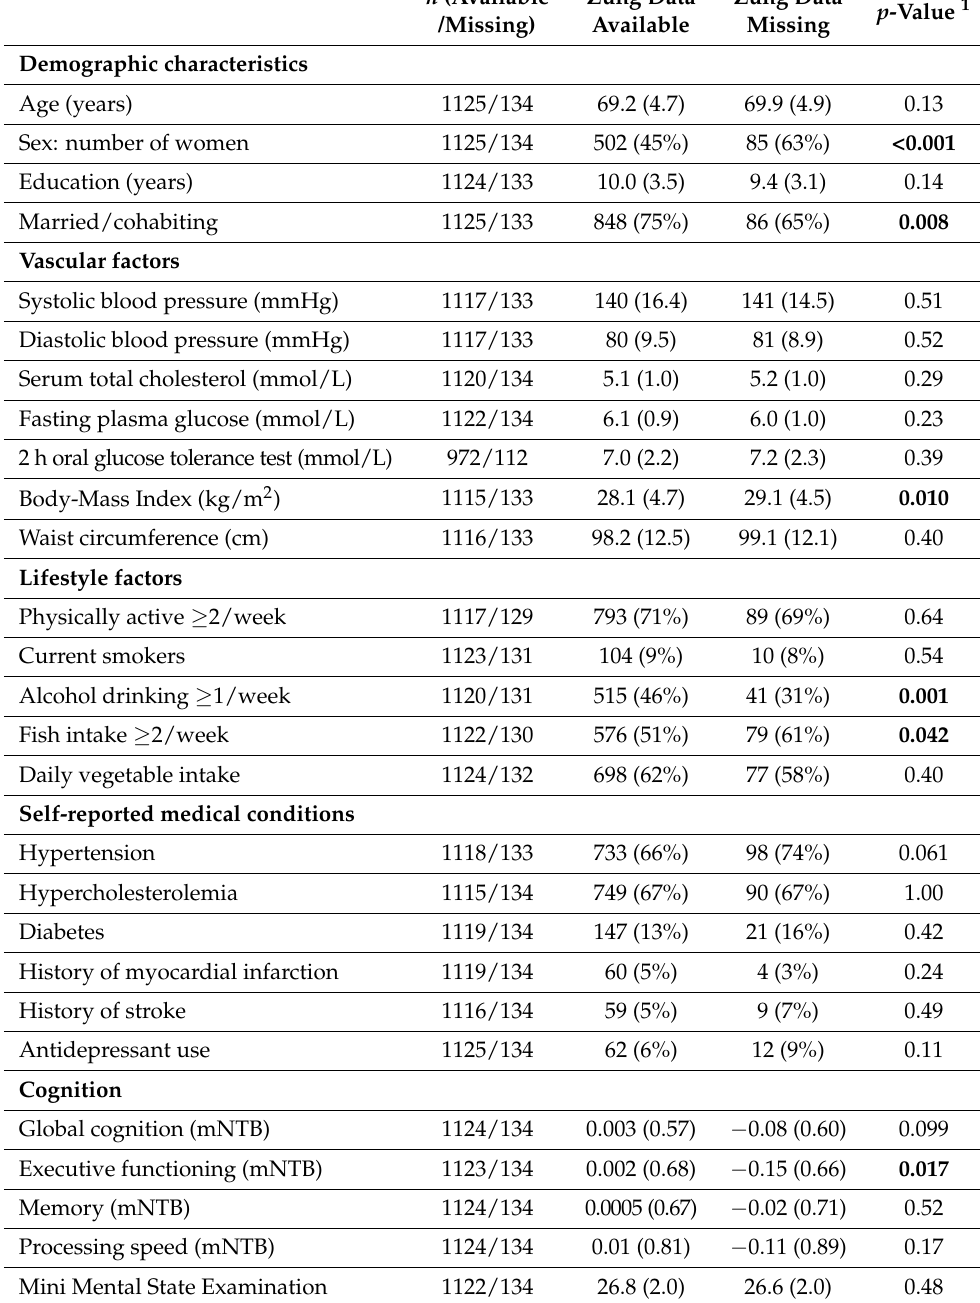
n (Available Zung Data Zung Data p -Value /Missing) Available Missing